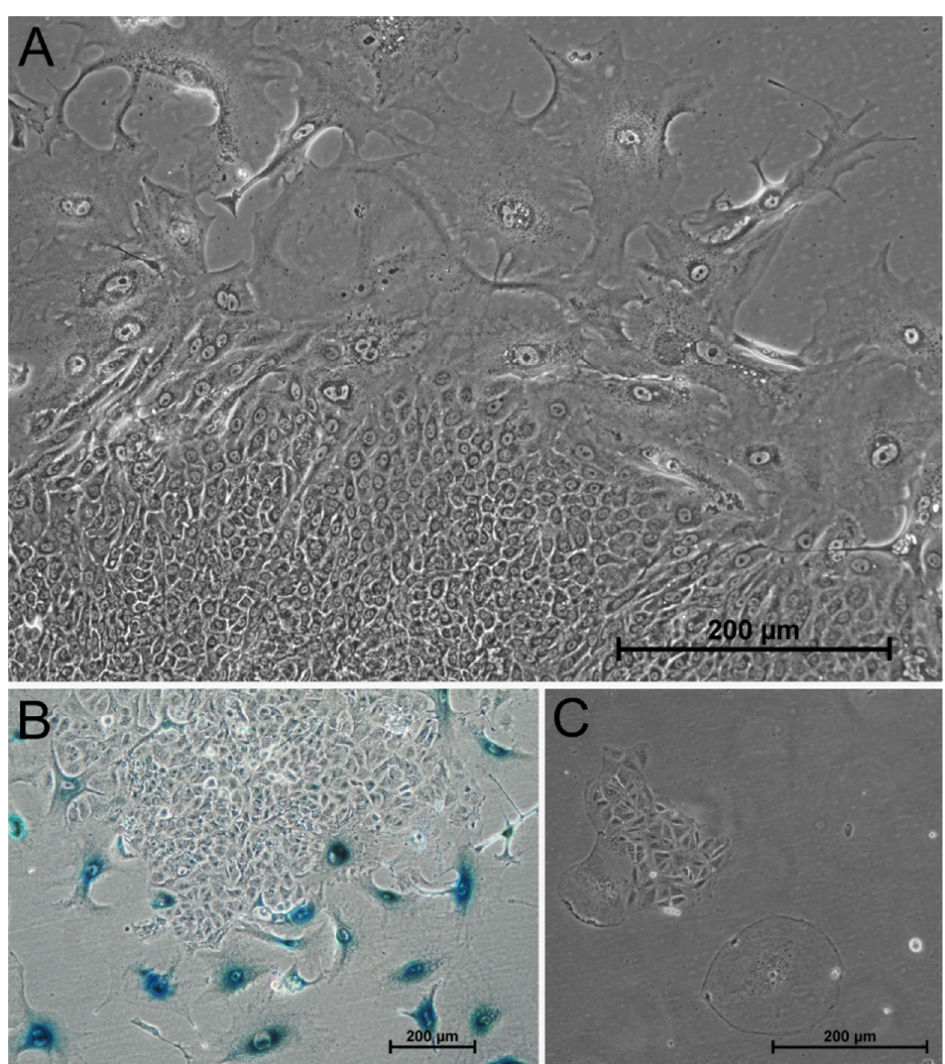
Figure 10. Regrowing tumor cells of the cell lines A549 and HuH-7 weeks after treatment with 16 Gy. Section ( A ) shows the morphology of A549 cells 70 days after treatment with 16 Gy. Small, highly proliferative cells appeared between the enlarged senescent cells and formed islands that began to grow and occupy progressively more space within the cell population. Their morphology indicated an escape from the senescent state. This was confirmed by senescence-associated β -galactosidase staining ( B ) of A549 cells 52 days after treatment with 16 Gy. It showed that the small cells in the islands lost positive staining. Additionally, HuH-7 cells were able to regrow after 28 days after 16 Gy irradiation (morphology shown in C ). Between the giant senescent HuH-7 cells, small islands of proliferating tumor cells appeared again.